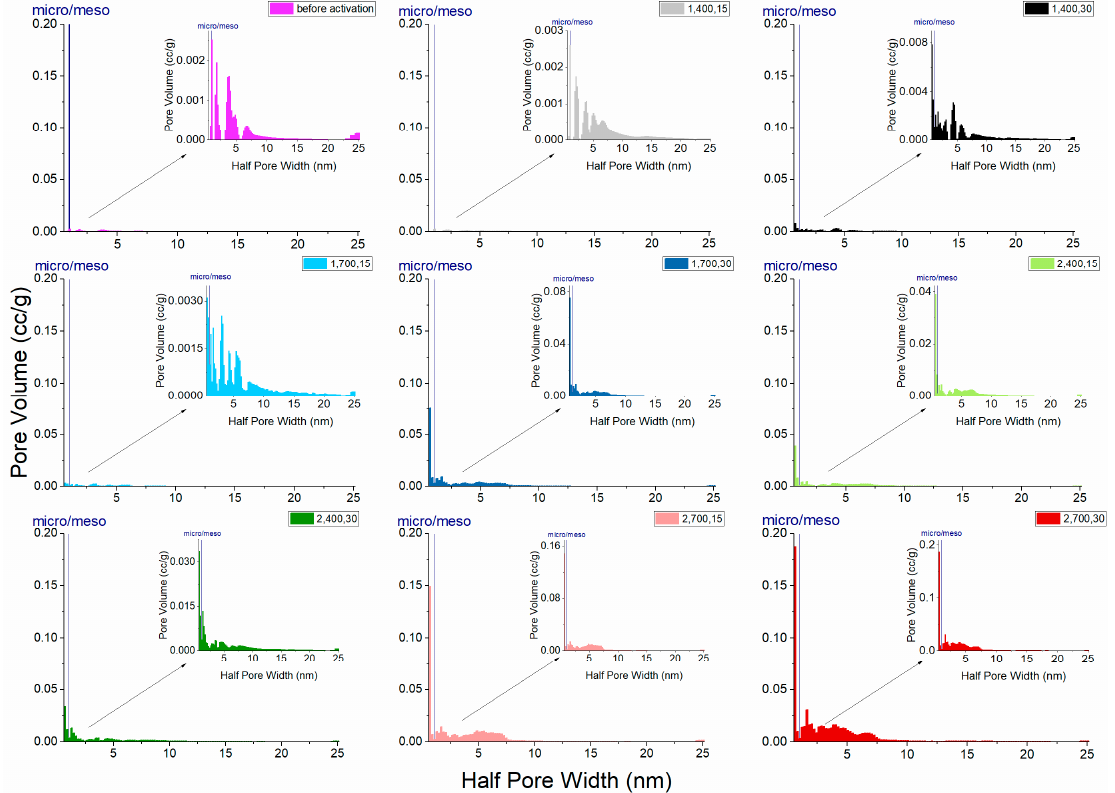
Figure 7. Pore-size distribution of the LACFs, for each legend, 1, 2: 1- or 2-step; 400, 700: carbonization temperature (°C); 15, 30: activation time (min). Table 3. Specific surface area of produced LACFs.